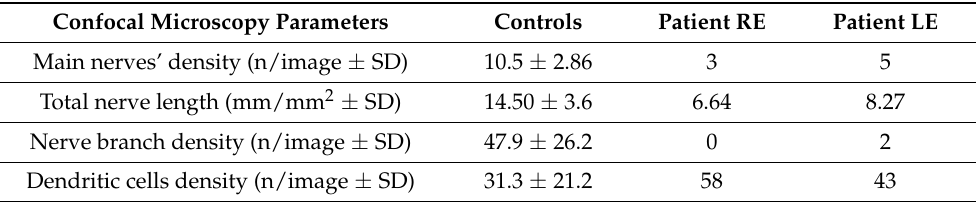
Table 2. Confocal microscopy parameters in the affected patient compared to a control group.